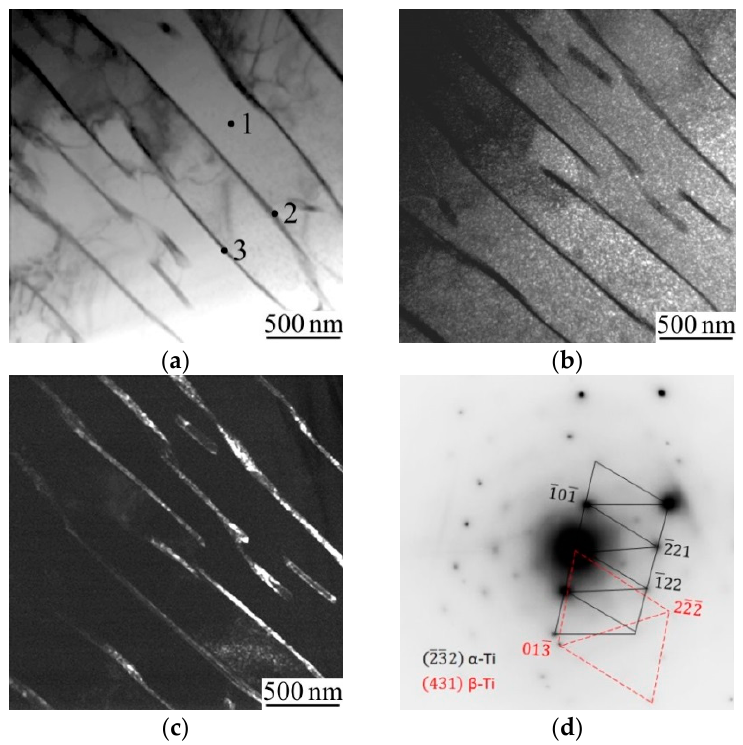
Figure 4. Bright- ( a ) and dark-field TEM micrographs ( b , c ) and the associated selected area electron diffraction (SAED) pattern with an indexing scheme ( d ) of the microstructures of the EBAM Ti-6Al-4V sample produced without substrate